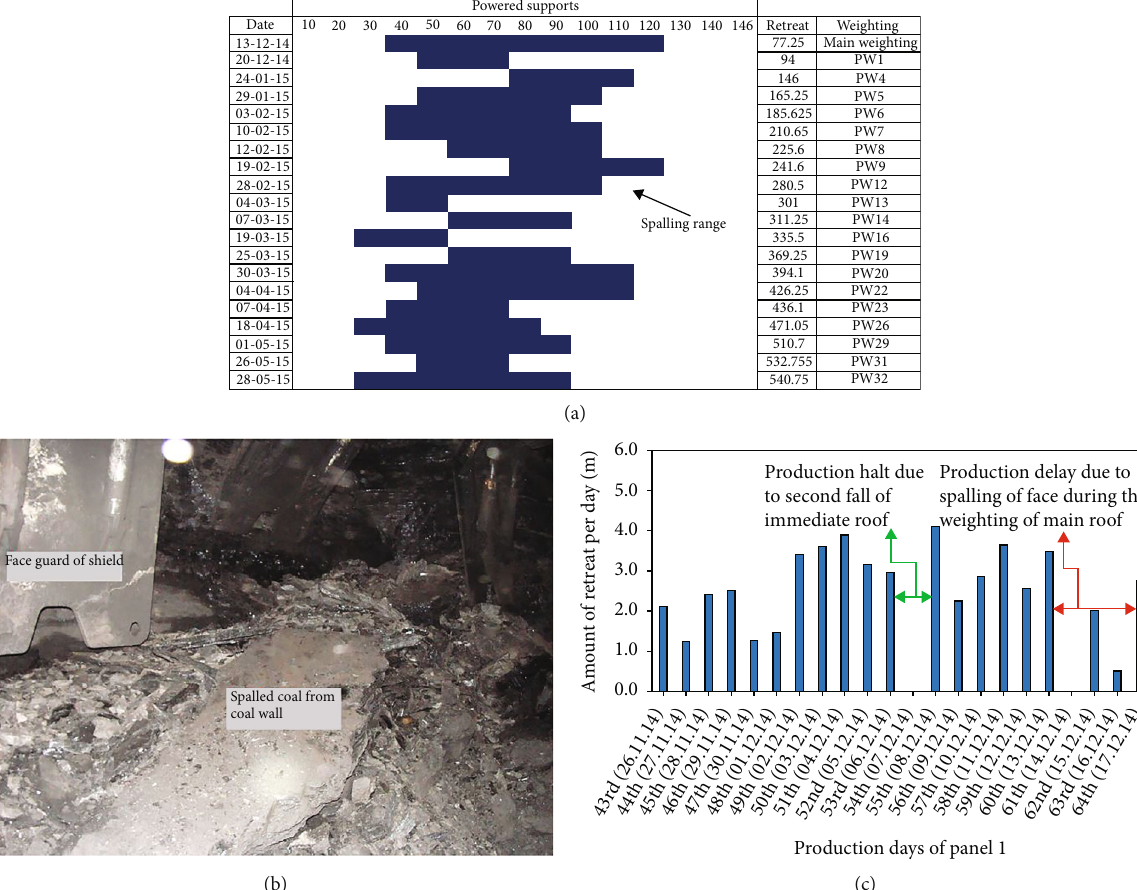
Figure 2: (a, b) Coal wall spalling occurrence during the MWP of panel 1; ALP (c) slow face retreat due to coal wall spalling in panel 1 of ALP.